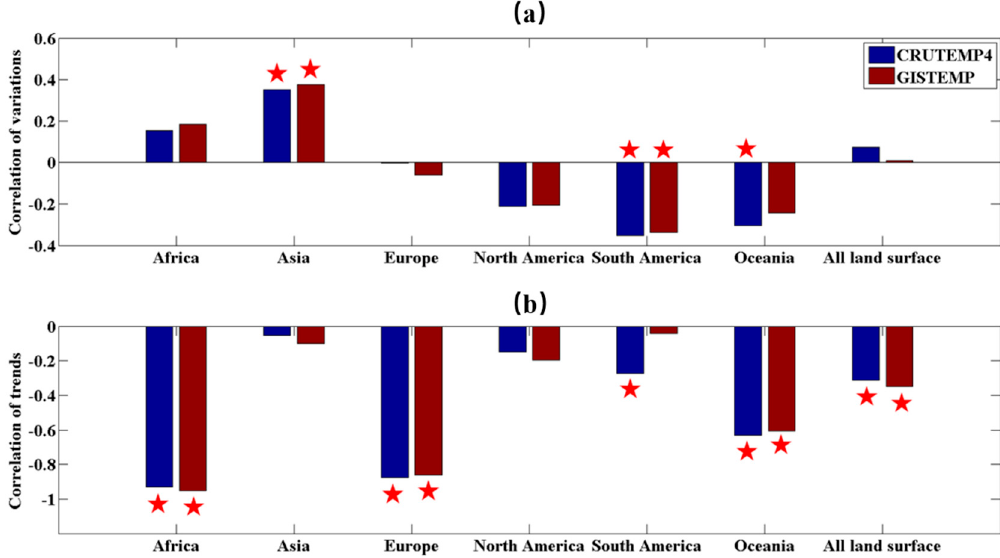
Figure 5. Same as Figure 4 but for the correlations between ( a ) the detrended time series of annual surface air temperature and discharge from 1948 to 2004; ( b ) the trends of surface air temperature and discharge from 1948 to 2004; the red star represents significant correlation at the 95% level.